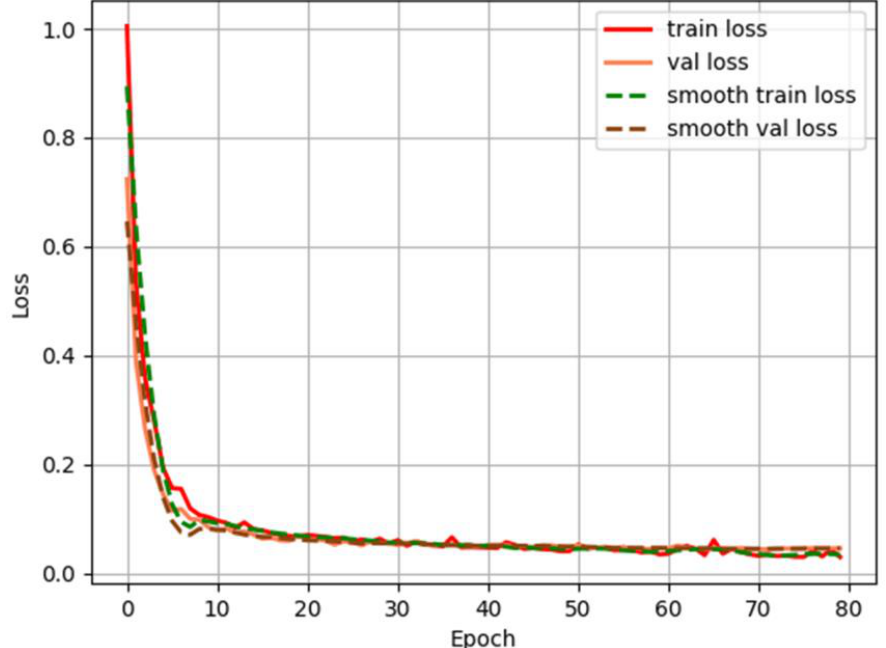
Figure 10. Loss function curve.